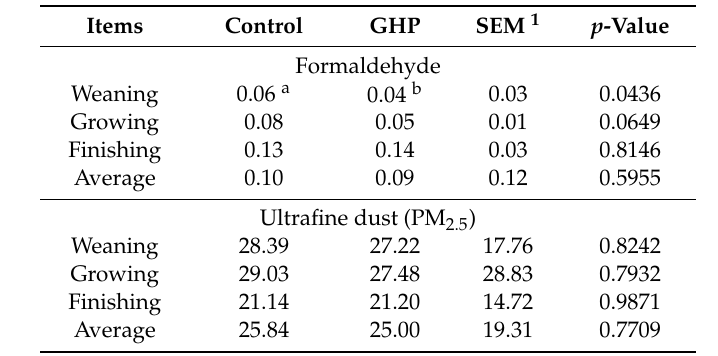
Table 4. E ff ect of the geothermal heat pump (GHP) on formaldehyde (ppm) and ultrafine dust (PM 2.5 ) ( µ g / m 3 ) in the pig